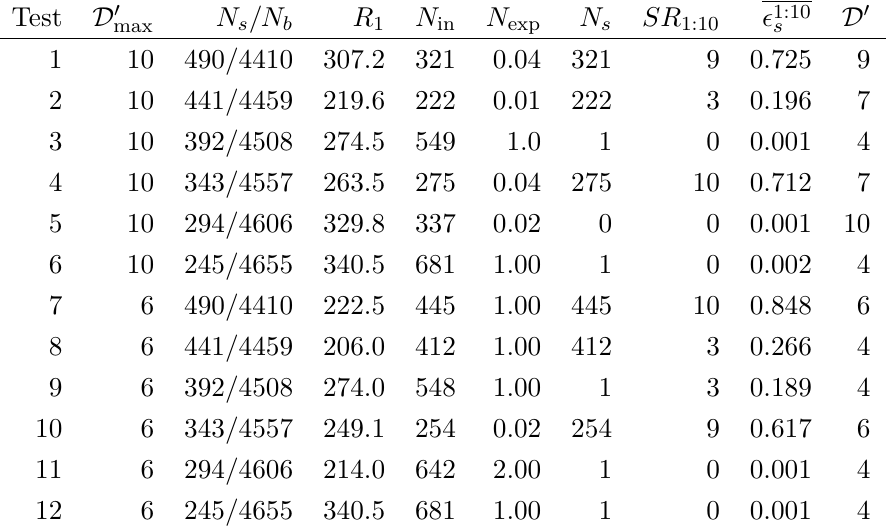
Table 11 . Results of RanBoxIter on a 4900-event sample of fraud detection data, using two values for the maximum dimensionality D 0 and signal contamination fractions varying from 5% to 10%. SR 1:10 reports the number of signal-rich boxes among the 10 with highest test statistic. See the text for other